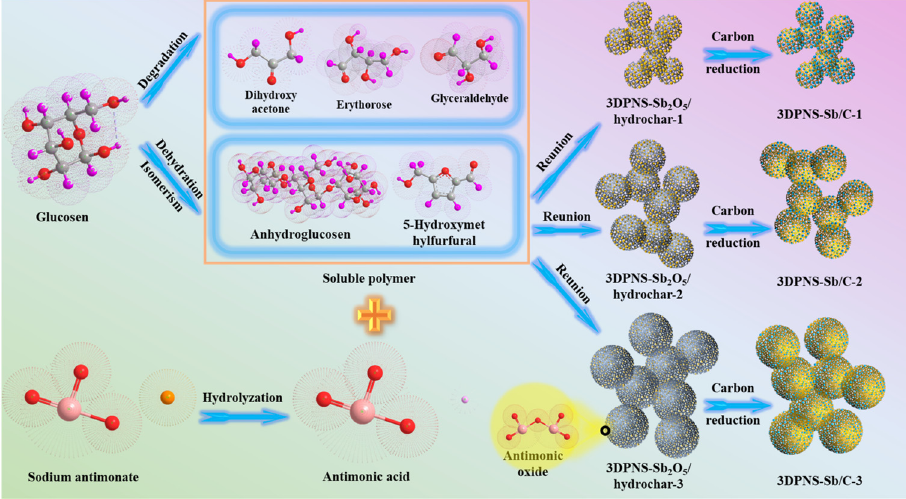
Figure 1. Schematic picture of the synthesis process of 3DPNS-Sb/C nanoparticle materials.